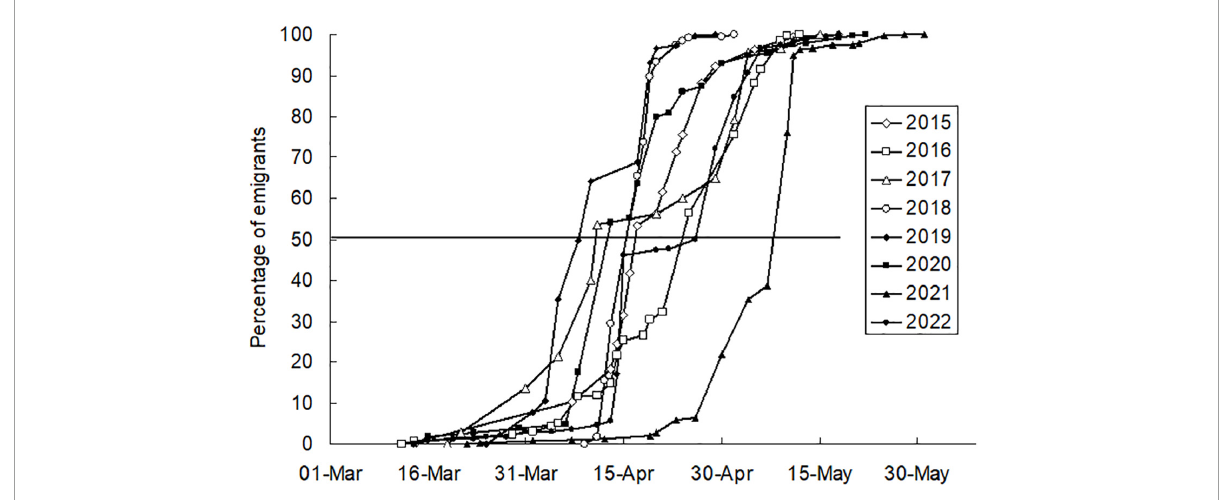
FIGURE6 Emigration from an artificial hibernaculum, 2015–2022. Cumulative percentage of individuals who that left the artificial hibernaculum plotted against the date of emigration.